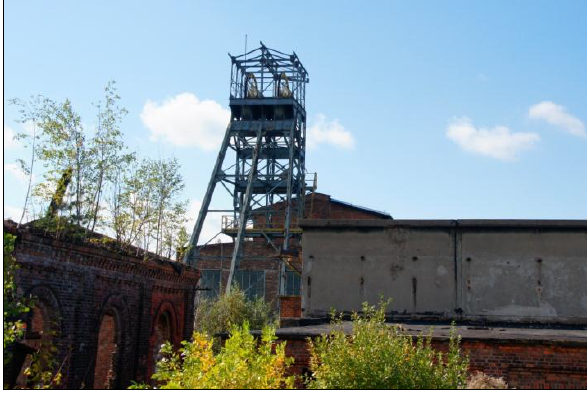
Fig. 2. "Klara" shaft in abandoned mine "Wawel" ( K. Mazurek